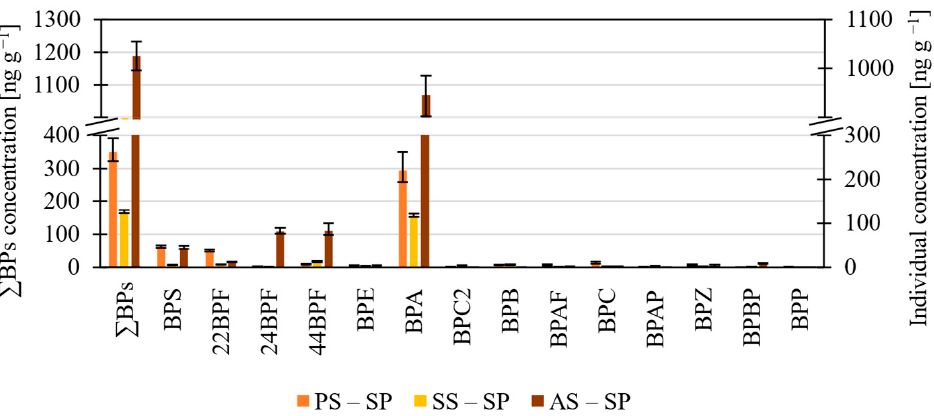
Figure 4. Histogram showing the levels of BPs in the solid phase of primary (PS–SP), secondary (SS– SP) and anaerobically stabilized sludge (AS –